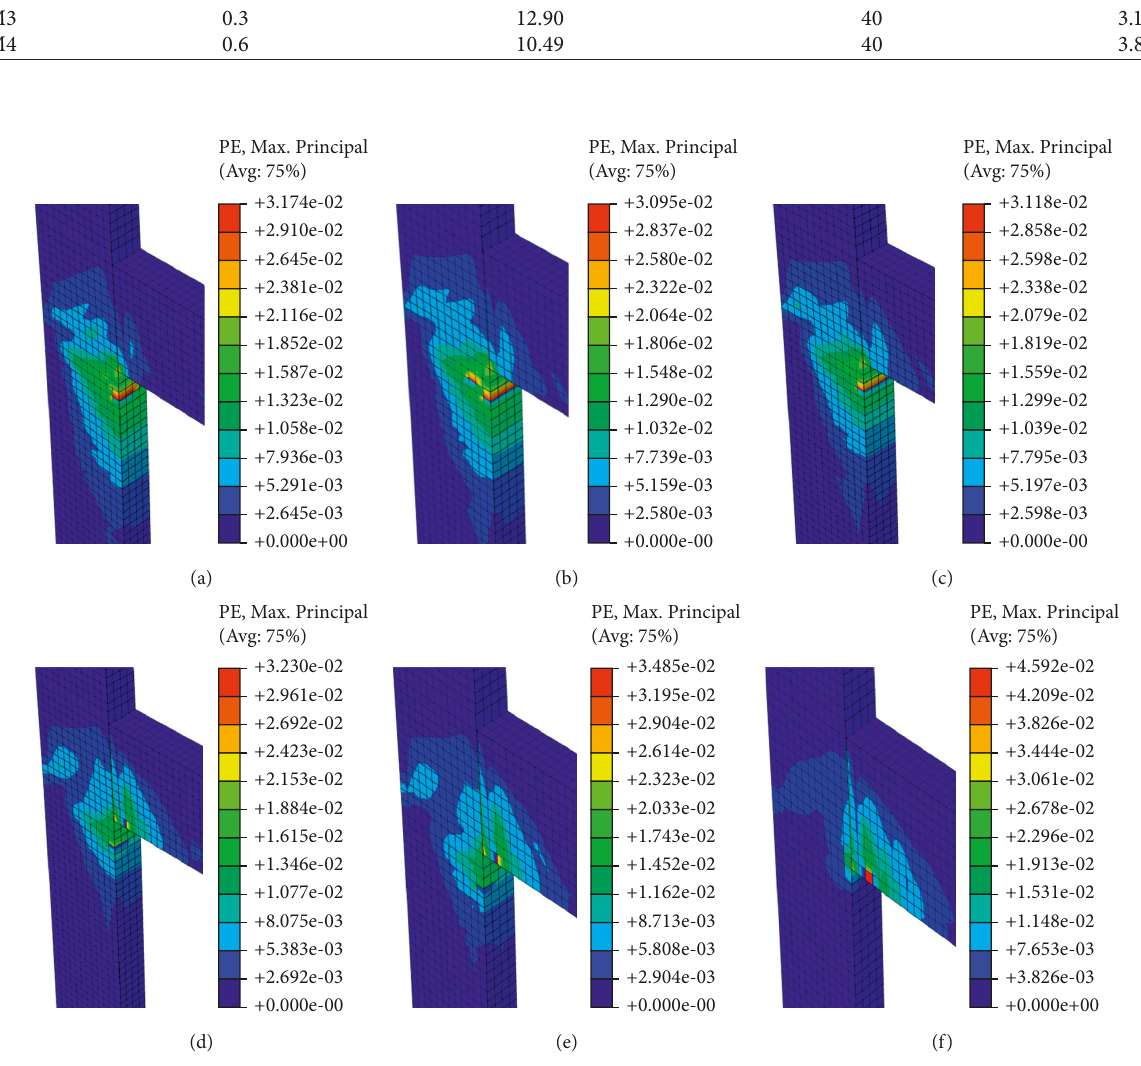
Figure 15: Crack pattern for specimens with various axial load ratios: (a) G1M0, no axial force; (b) G1M1, 0.1; (c) Referential, 0.133; (d) G1M2, 0.26; (e) G1M3, 0.3; and (f) G1M4, 0.6.